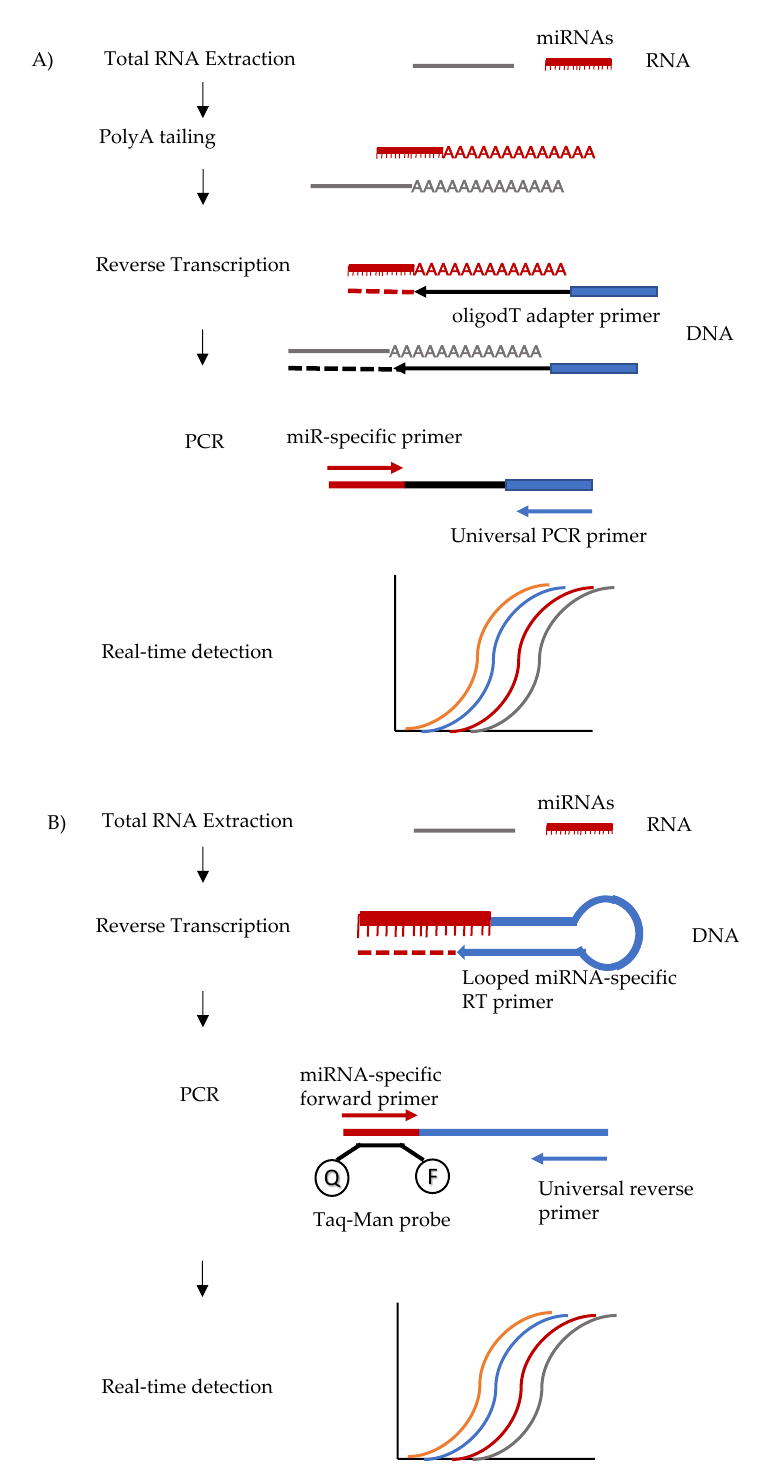
Figure 3. Diagram of quantitative PCR workflow. ( A ) Qiagen and Exiqon methodologies employ PolyA tailing which allows reverse transcription using a universal oligodT primer. This decreases the method’s specificity but improves sensitivity. Real-time detection is enabled by Sybr-green or similar intercalating fluorophores. ( B ) TaqMan RT-qPCR relies on miRNA-specific RT and PCR primers, and therefore has the disadvantage of needing reverse transcription being done for each miRNA separately. This method has high specificity but slightly lower sensitivity than others. Real time detection is based on miRNA-specific Taq-Man probes. Q = quencher; F =